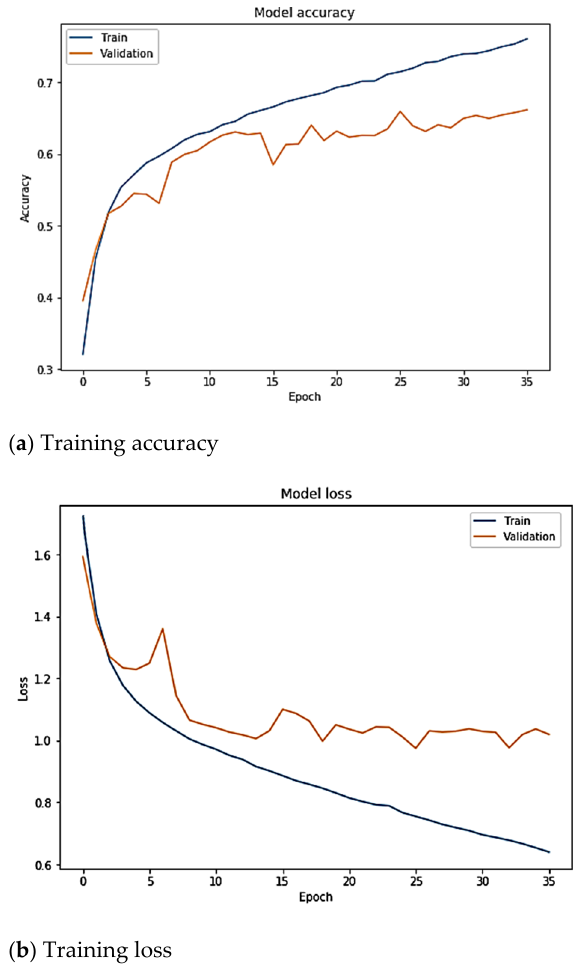
Figure 11. Training accuracy and loss of Mini_Xception model Architecture.